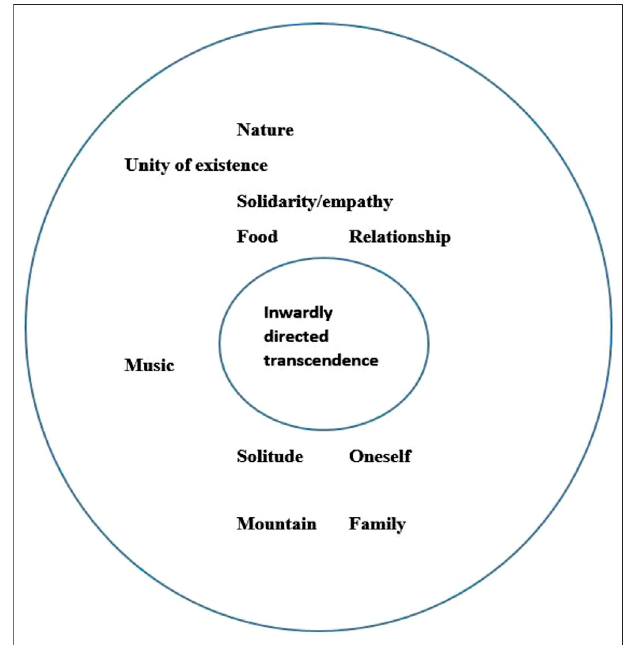
FIGURE 2 | Sacred core and ring (Ahmadi and Ahmadi, 2018, p.130, p.130).